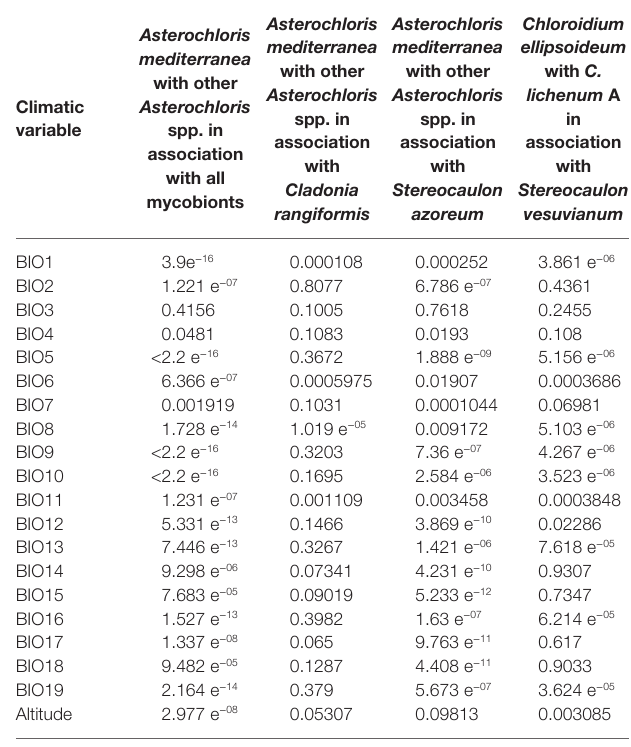
TABLE 2 | Results of Welch’s t -tests ( p ) performed for contrasting pairs of phycobionts in combination with their